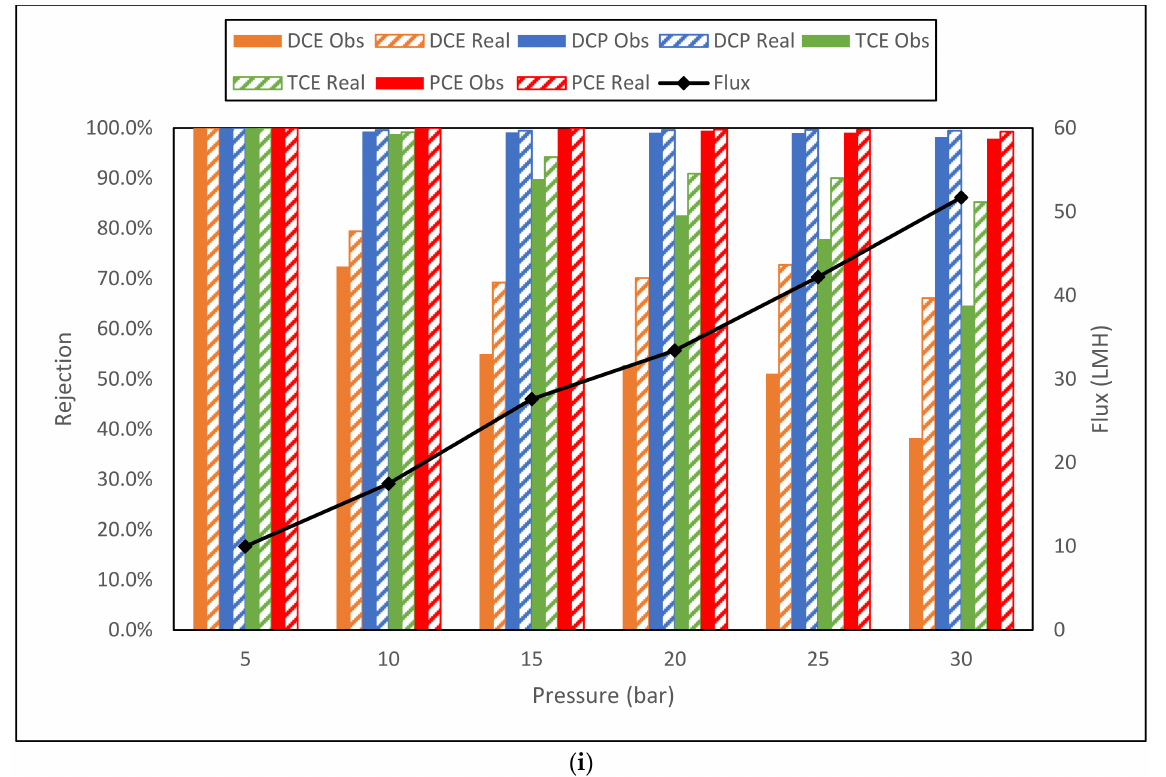
Figure 10. ( a ) Dow NF90 membrane flux (LMH) and observed and real rejection data for VOC solution using GC–MS HS analysis. ( b ) Dow N270 membrane flux (LMH) and observed and real rejection data for VOC solution using GC–MS HS analysis. ( c ) GE DK membrane flux (LMH) and observed and real rejection data for VOC solution using GC–MS HS analysis. ( d ) GE DL membrane flux (LMH) and observed and real rejection data for VOC solution using GC–MS HS analysis. ( e ) GE AK membrane flux (LMH) and observed and real rejection data for VOC solution using GC–MS HS analysis. ( f ) GE AG membrane flux (LMH) and observed and real rejection data for VOC solution using GC–MS HS analysis. ( g ) Dow BW30 membrane flux (LMH) and observed and real rejection data for VOC solution using GC–MS HS analysis. ( h ) Dow BW30LE membrane flux (LMH) and observed and real rejection data for VOC solution using GC–MS HS analysis. ( i ) Dow BW30XFR membrane flux (LMH) and observed and real rejection data for VOC solution using GC–MS HS